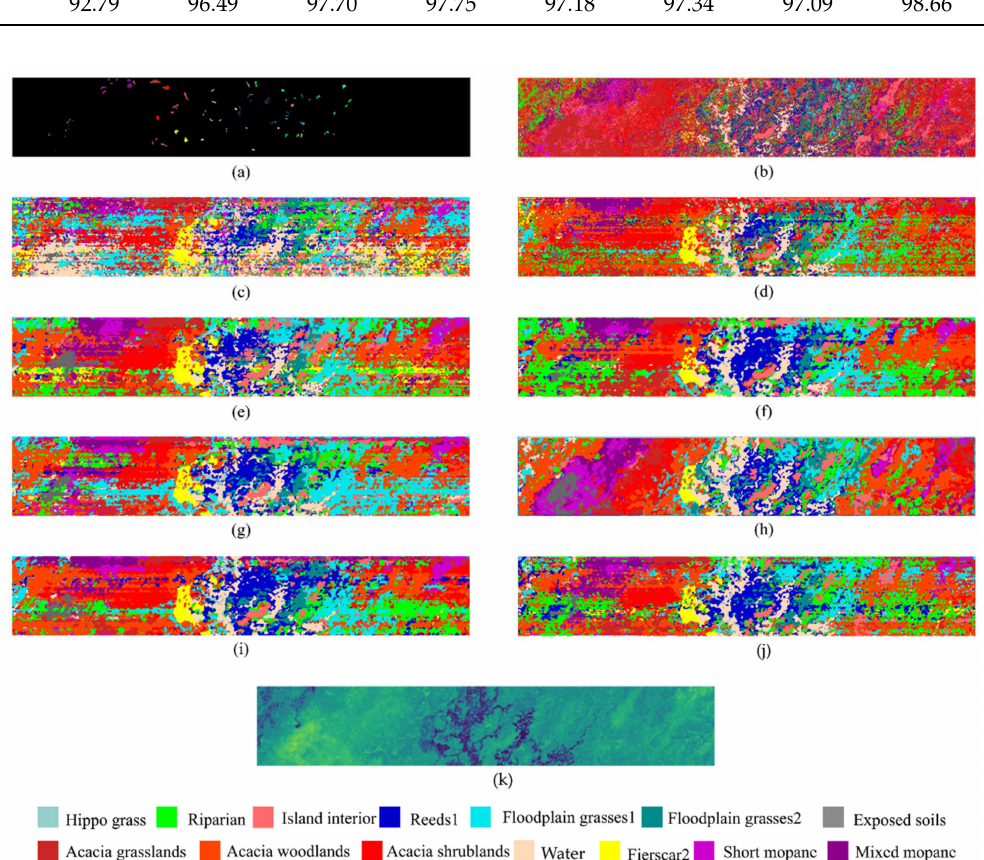
Figure 9. Full-factor classification maps for the BS dataset. ( a ) Ground-truth. ( b ) SVM. ( c ) HYSN. ( d ) SSRN. ( e ) FDSS. ( f ) DBMA. ( g ) DBDA. ( h ) PCIA. ( i ) SSGC. ( j ) OSDN. ( k ) False-color